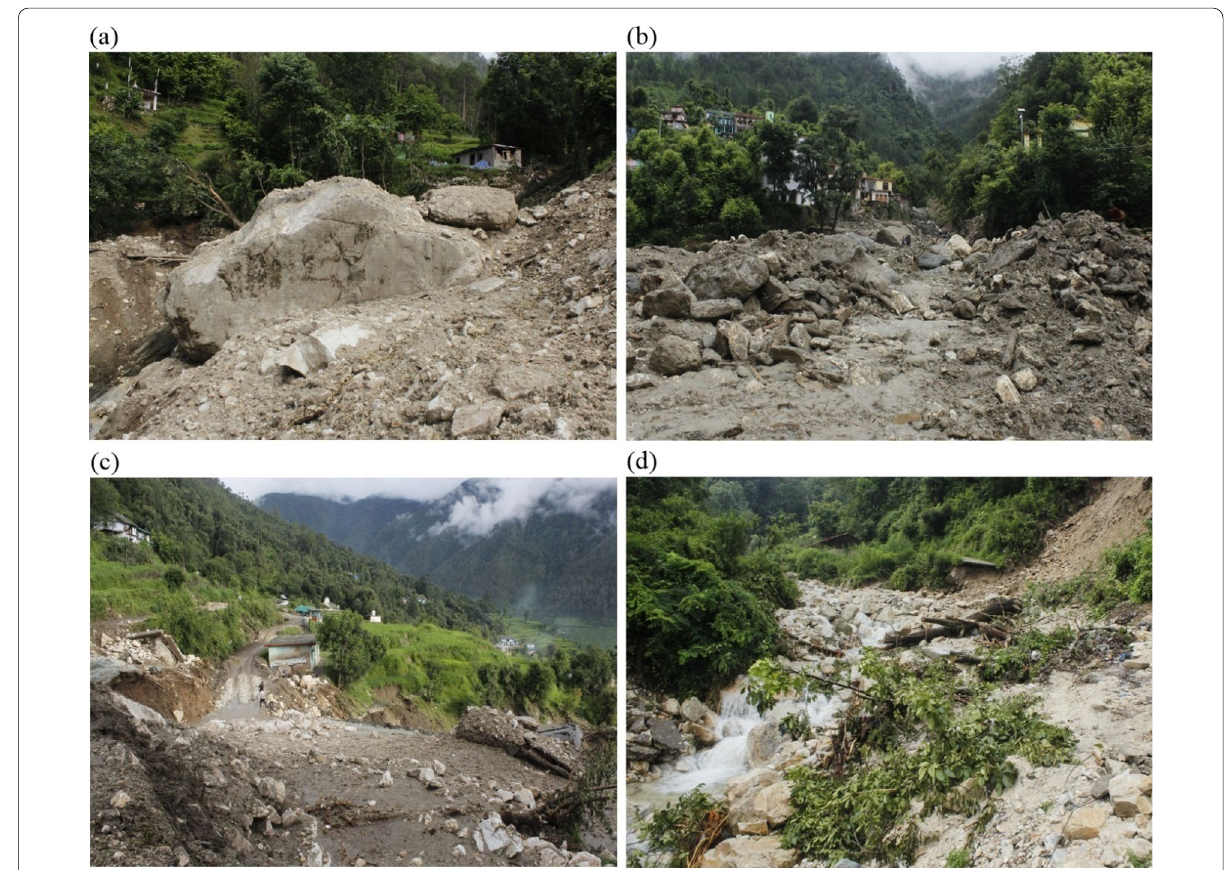
Fig. 5 Cloudburst affected villages a Nirakot, b Mando, c Kankrari, d Siror; Photo: by authors